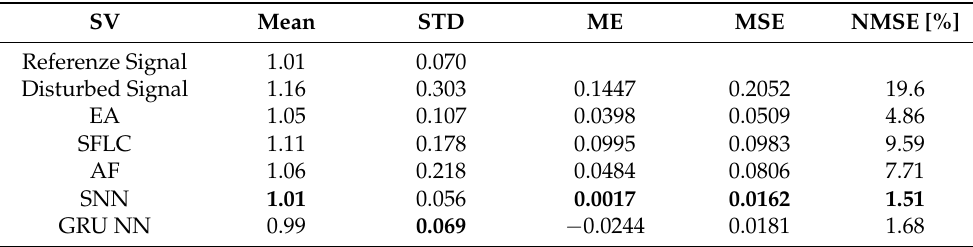
Table 2. SV results for force tests.